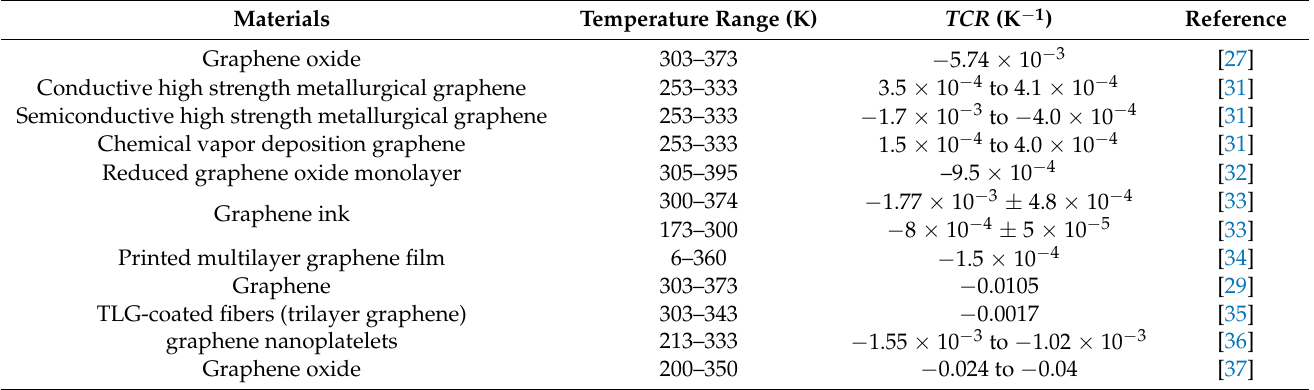
Table 3. Comparison of temperature dependences of graphene-based